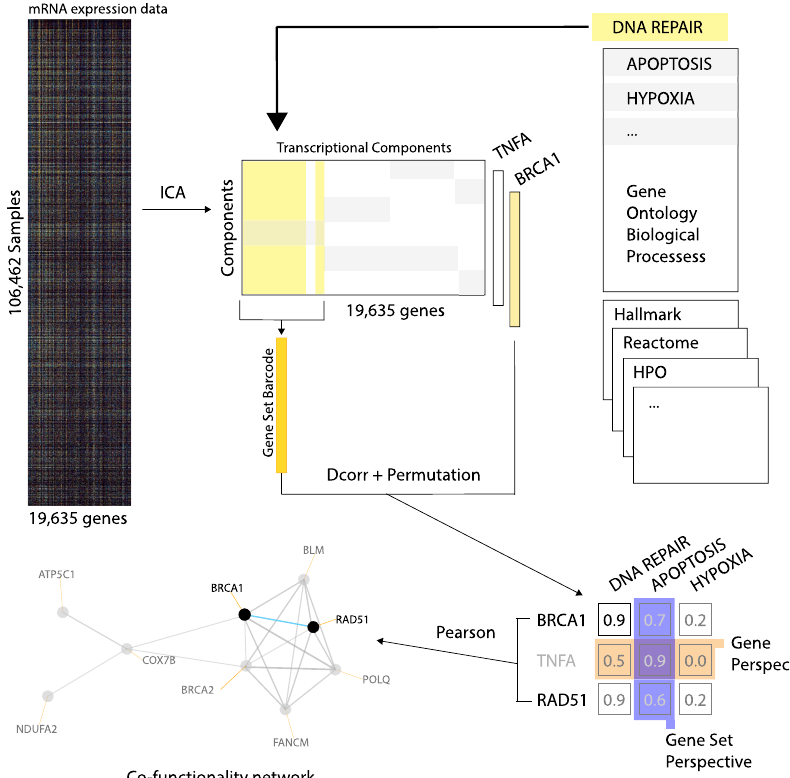
Fig. 1 Overview of the guilt-by-association methodology to calculate prediction scores. Transcriptional components (TCs) are calculated from a large mRNA expression dataset using c-ICA or PCA. For every gene set in a gene set collection, a vector of means (transcriptional regulatory barcode) is calculated by taking the mean vector of weights in the mixing matrix of genes that are members of the gene set. The correlation of each gene and each barcode is calculated using distance correlation and a Z-transformed p value is estimated by performing a permutation test. The resulting Z-transformed p values constitute prediction scores that can be interpreted as a ranking of gene set memberships predicted for a gene (gene perspective). Alternatively, they can be interpreted as a ranking of genes predicted as members of a single gene set (gene set perspective). Finally, a gene-to-gene correlation matrix is calculated from the prediction scores and used to cluster genes in the force-directed layout of the co-functionality network visualization.